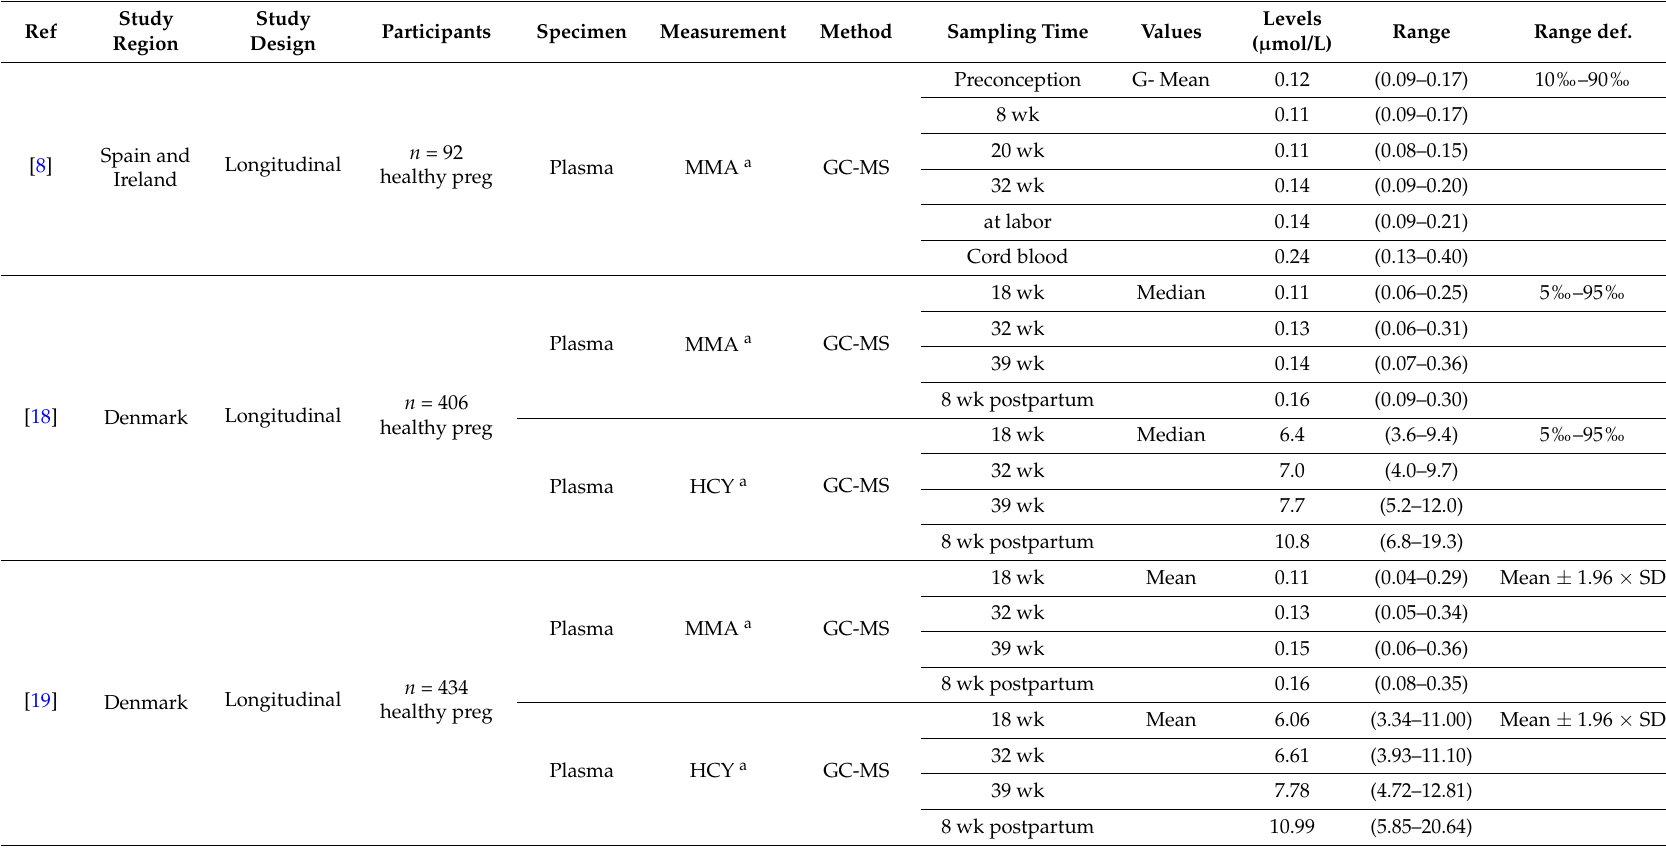
Table 4. Methylmalonic acid and homocysteine levels in pregnant women in previously reported